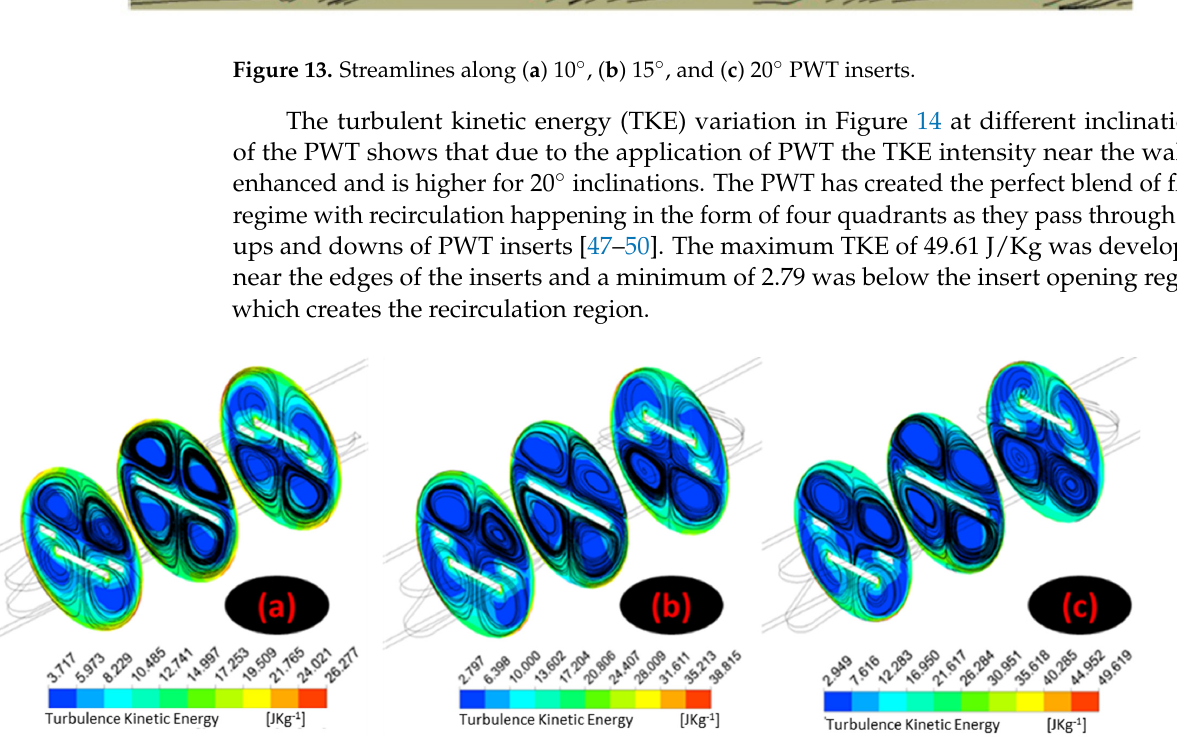
Figure 14. TKE distribution along ( a ) 10°, ( b ) 15° and ( c ) 20° PWT inserts at section x 1 , x 2 and x 3 .